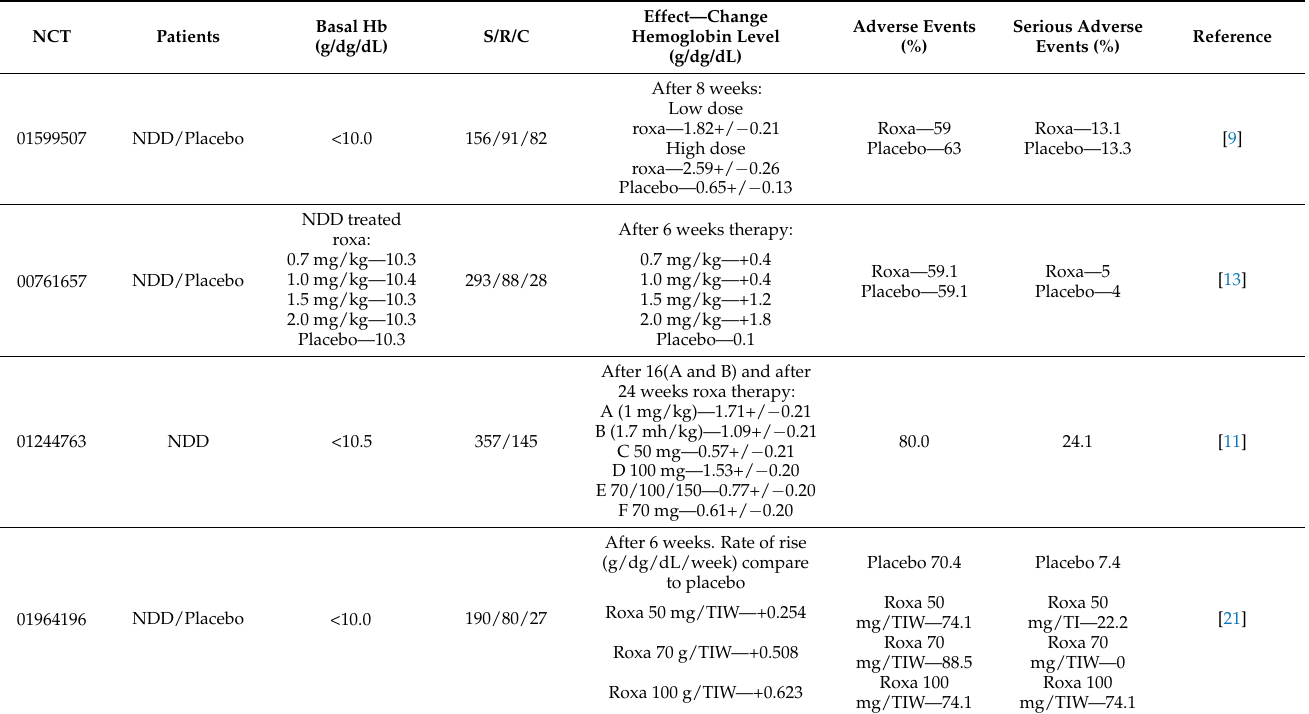
Table 1. Summary of the results of phase 2 studies of roxadustat use in patients with renal failure not undergoing dialysis [NDD]. Patients